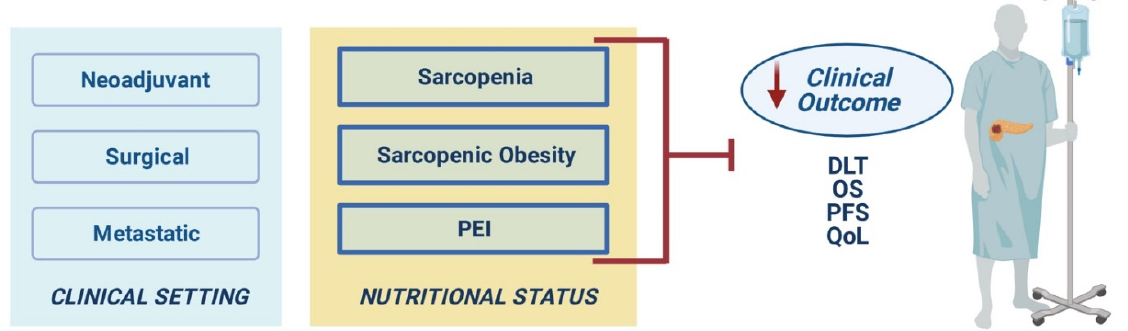
Figure 2. Clinical impact of malnutrition in different treatment settings. Abbreviations: PEI, pancreatic exocrine insufficiency; DLT, dose-limiting toxicities; OS, overall survival; PFS, progression-free survival; QoL, quality of life.